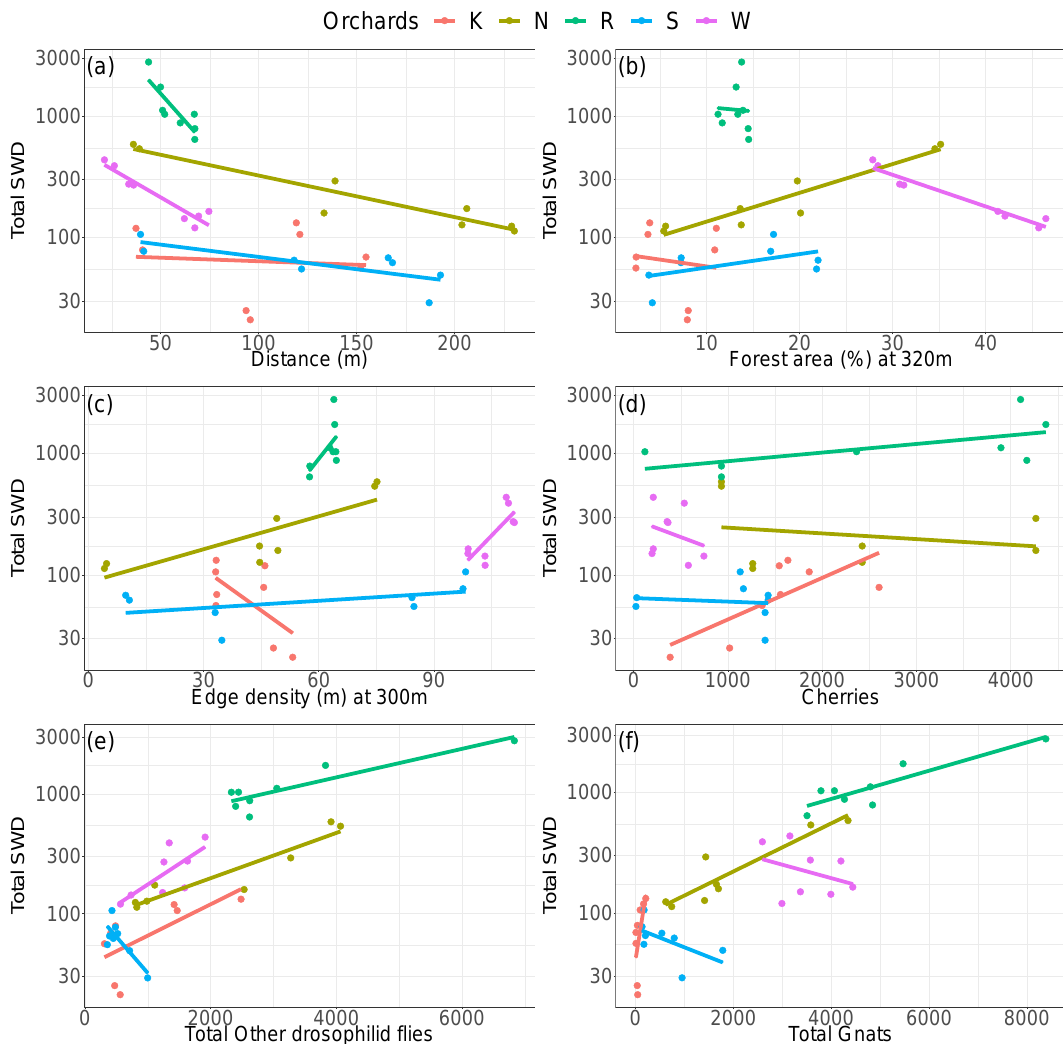
Figure 5. Scatterplots between trap catches of SWD and covariables at each orchard. SWD catches are log 10 -transformed. Lines are taken from ordinary regression analyses for each